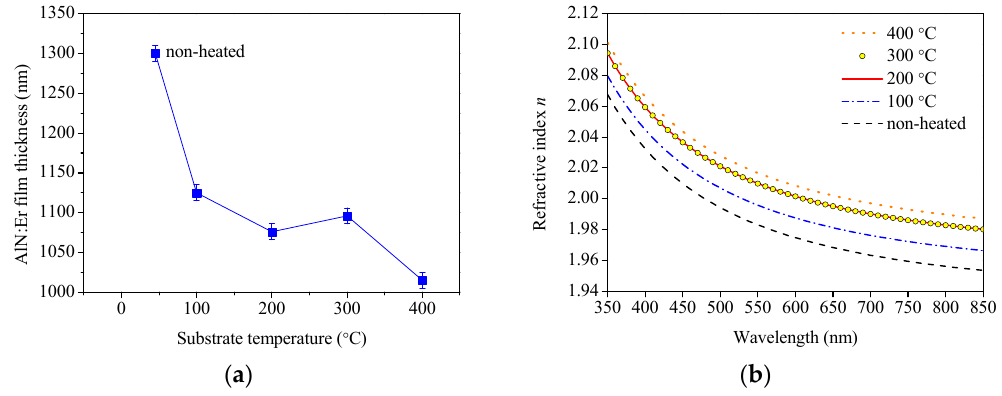
Figure 11. Dependence of AlN:Er film ( a ) thickness and ( b ) refractive index on the substrate temperature.